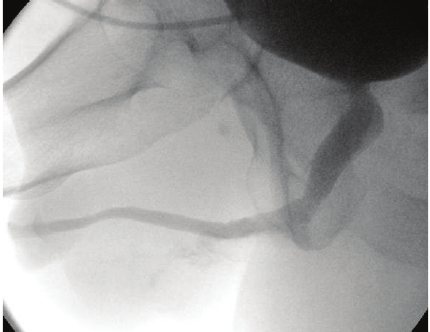
Figure 4: Voiding cystourethrography at 5 weeks.